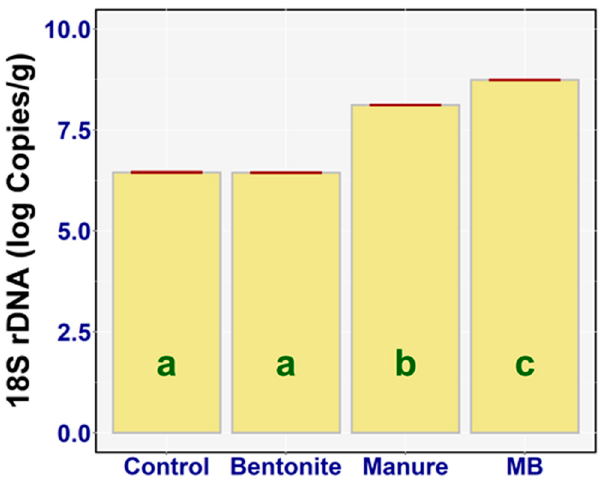
Figure 9. 18S rDNA (log copies/g) of the treatments: means with SEM.